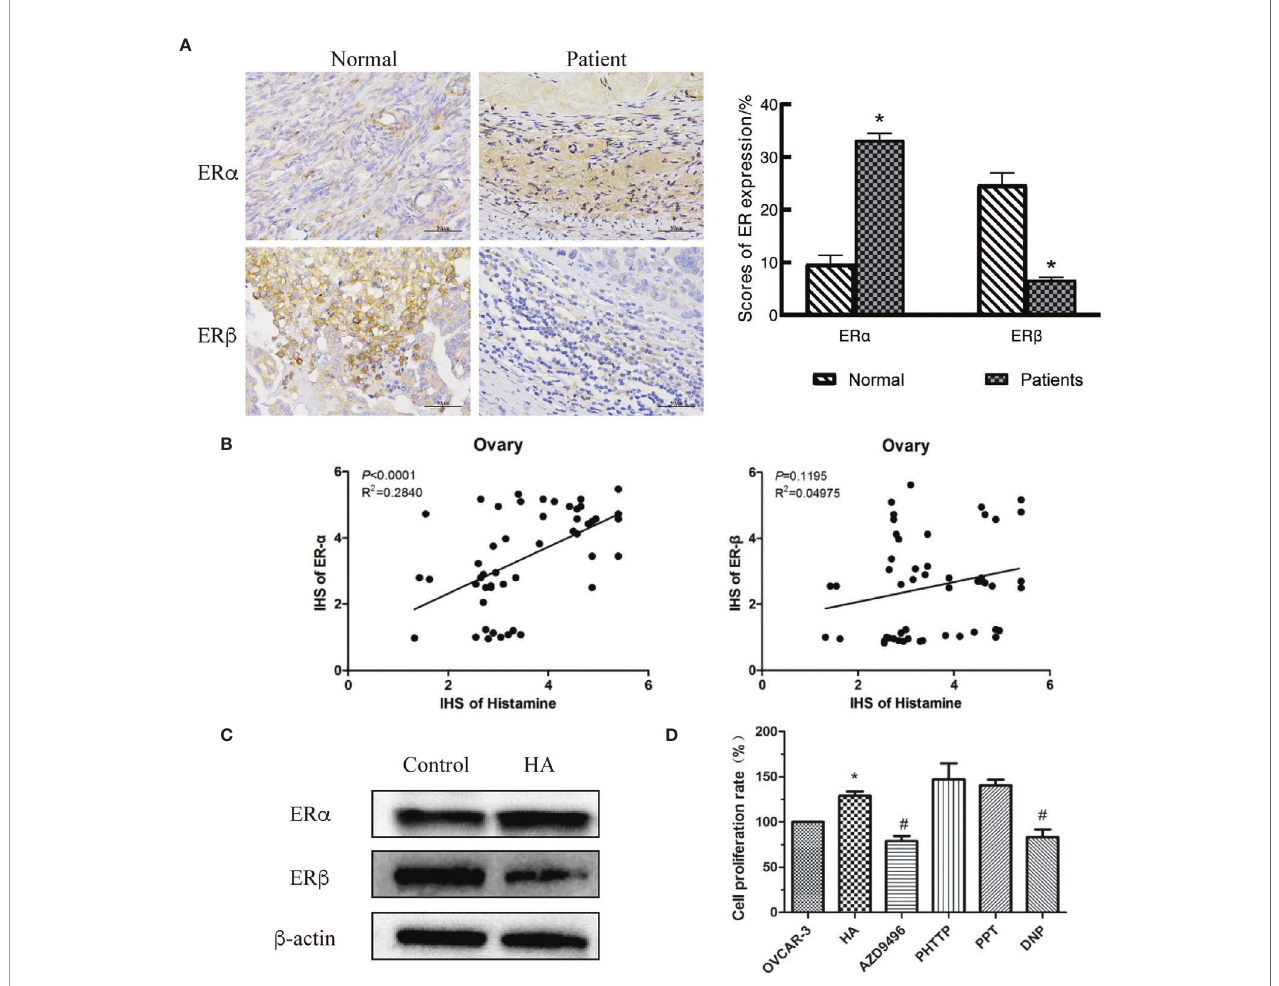
FIGURE 3 | Histamine induces the development of ovarian cancer by disordering expression of estrogen receptors (ERs). (A) Immunohistochemical detection of ovarian tissues, * P < 0.05 (compared to normal tissues). (B) Correlation analysis between histamine and ER a (left) 、 ER b (right) in ovarian cancer tissues. (C) Western blot analysis of the expression of ER a and ER b in histamine-treated OVCAR-3 cells. (D) Effect of Inhibiting or activating of estrogen receptors on the proliferation of OVCAR-3 cells. AZD9496, PHTTP, PPT, DNP are respectively ER a inhibitors, ER b inhibitors, ER a agonists, ER b agonists; * P < 0.05 (Compared to untreated OVCAR-3 cell group); # P < 0.05 (compared with the HA-treated